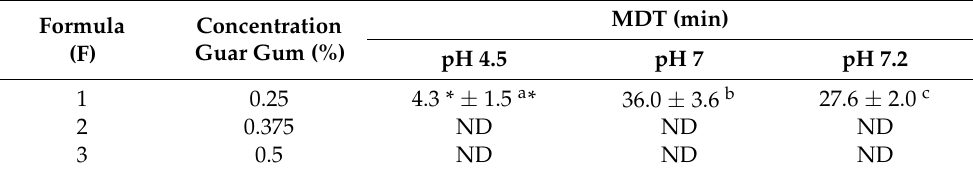
Table 3. Medium Drainage Time (MDT) in a maximum time of 60 min of the different foam-based formulations.